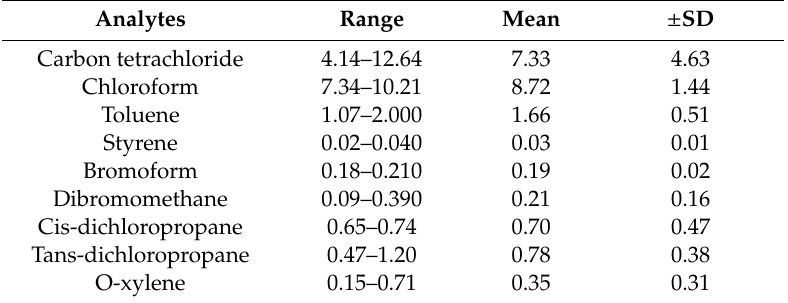
Table 6. Concentration ( µ g / L) range, mean, and standard deviation of VOCs leached from PVC